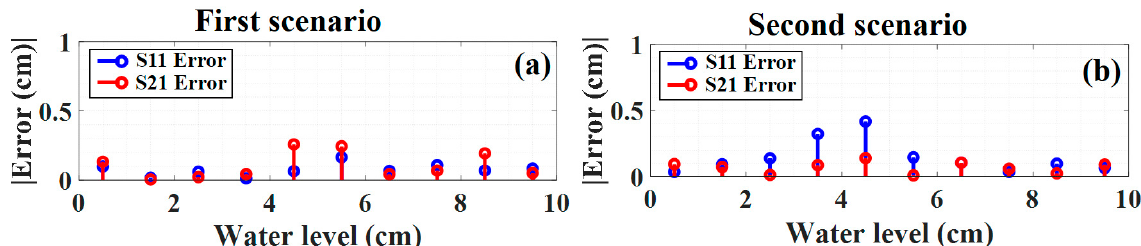
Figure 7. The water level prediction error versus the water level for the ( a ) first scenario and ( b ) second scenario.